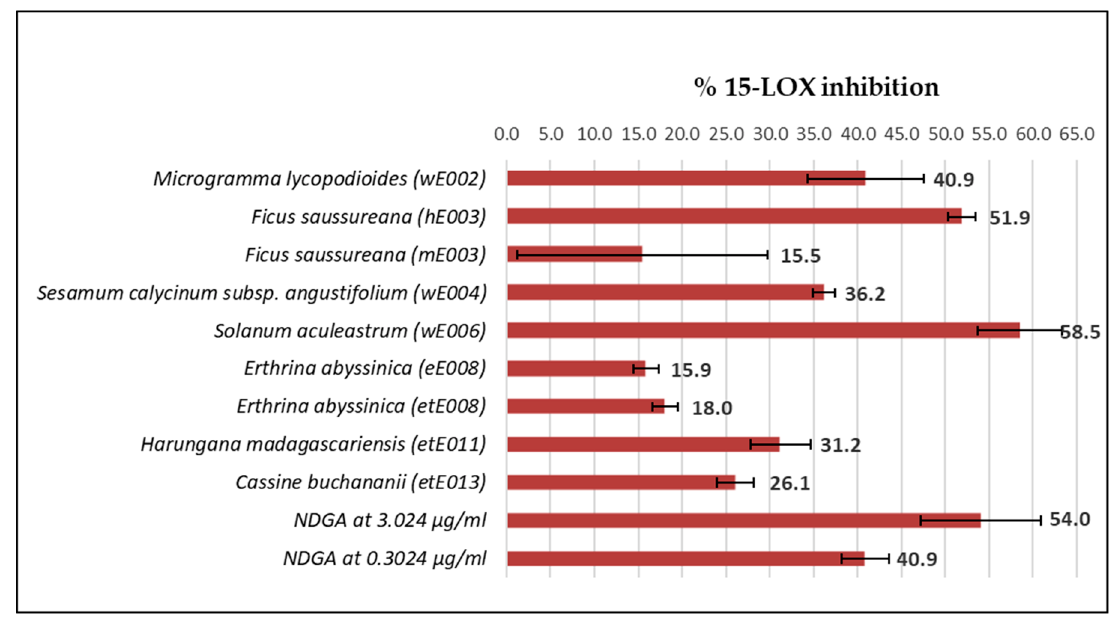
Figure 5. Results of the 15-LOX inhibition extract library counterscreen at 10 µg/mL; positive control tested at 3.024 µg/mL and 0.3024 µg/mL.